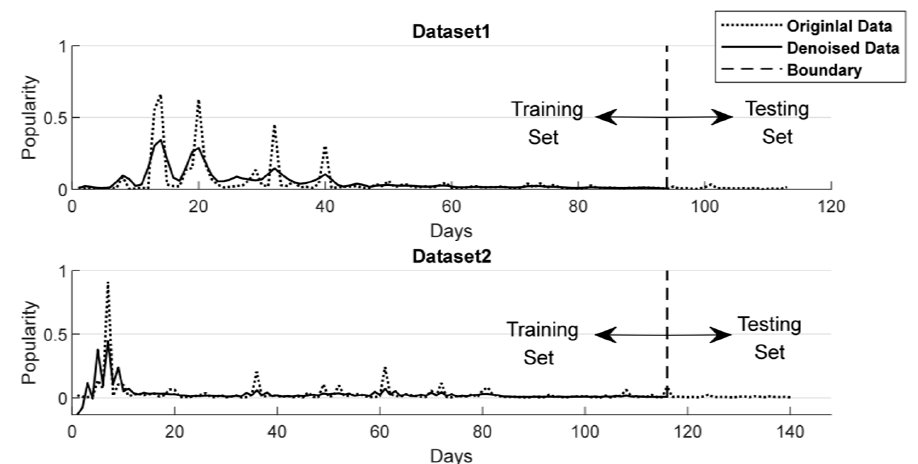
Figure 6. Comparison of popularity time series before and after denoising.